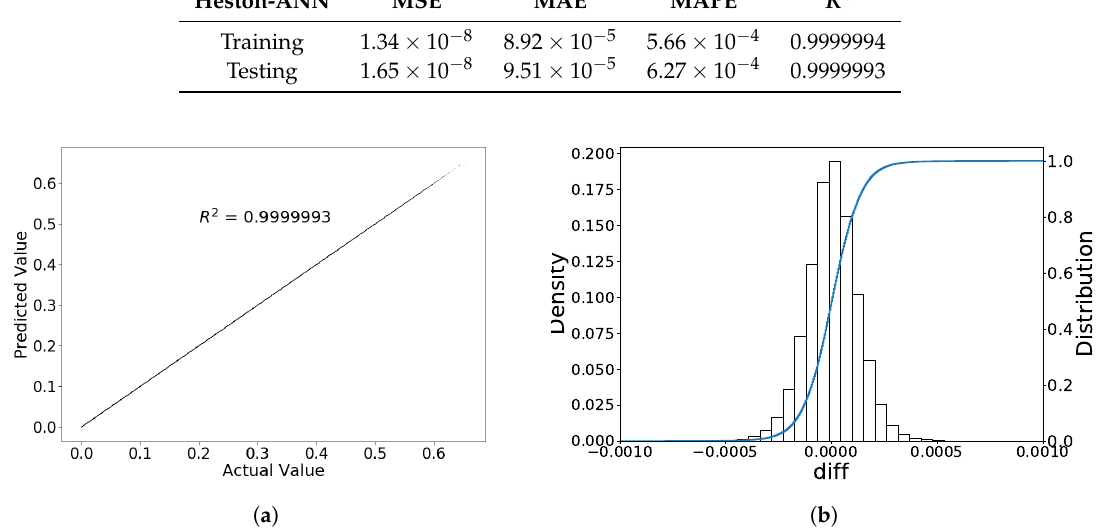
Table 10. The trained Heston-ANN performance.